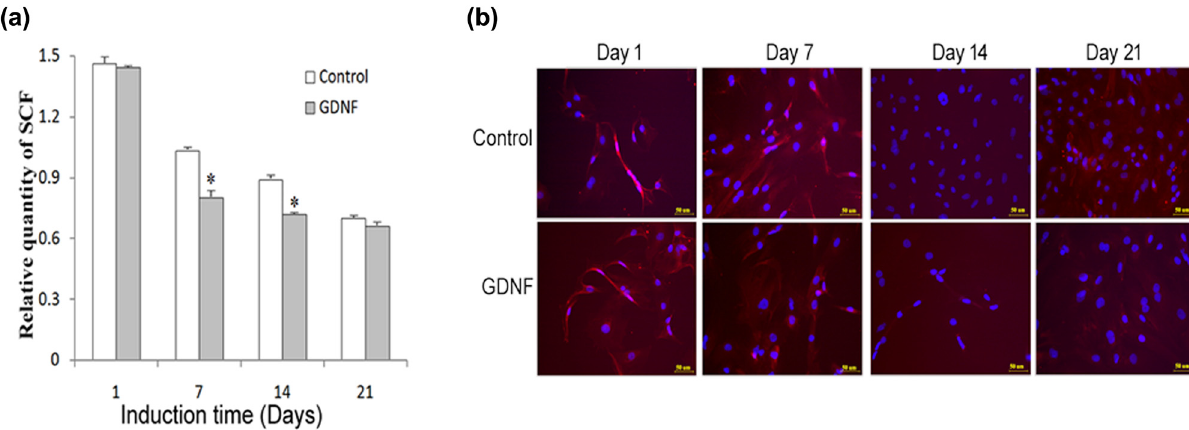
Figure 4: Detection of the level of SCF. ( a ) The gene expression of SCF in bone marrow stromal stem cells with GDNF treatment was estimated by qRT - PCR. ( b ) Immuno fl uorescence analysis of GDNF - treated bone marrow stromal stem cells. GDNF treatment decreases the number of SCF - positive cells. * p < 0.05 compared with the control